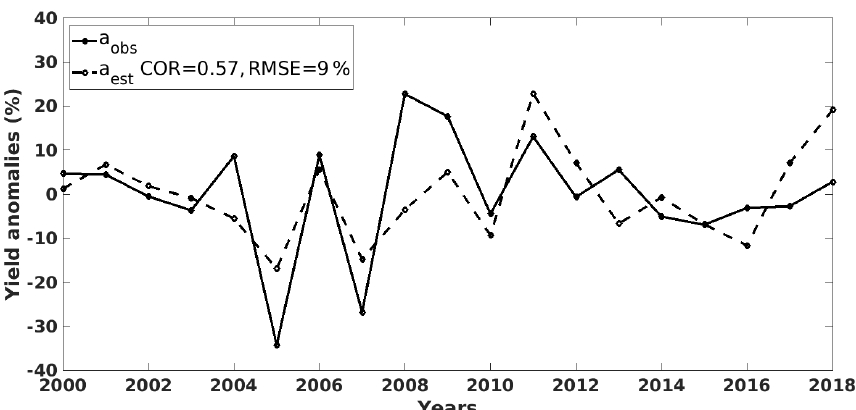
Figure 7. The observed (solid line) and LTO estimated (dashed line) coffee yield anomalies time series in Cu M’gar (Dak Lak,